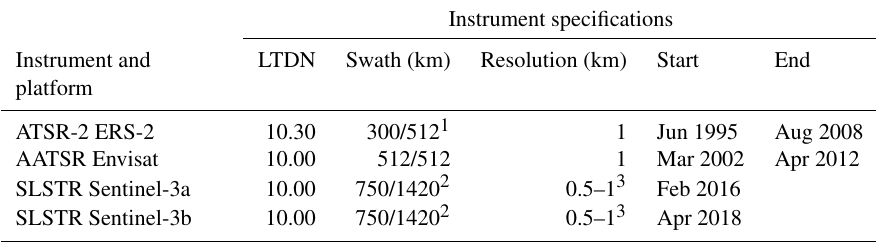
Table 1. Outline of the key specifications of the ATSR-2 and AATSR instruments compared to the follow-on SLSTR instruments. LTDN stands for local time descending